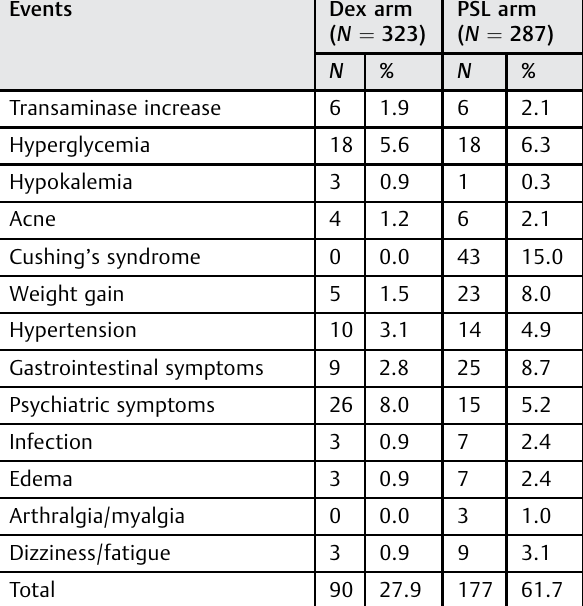
Table 2 Summary of adverse